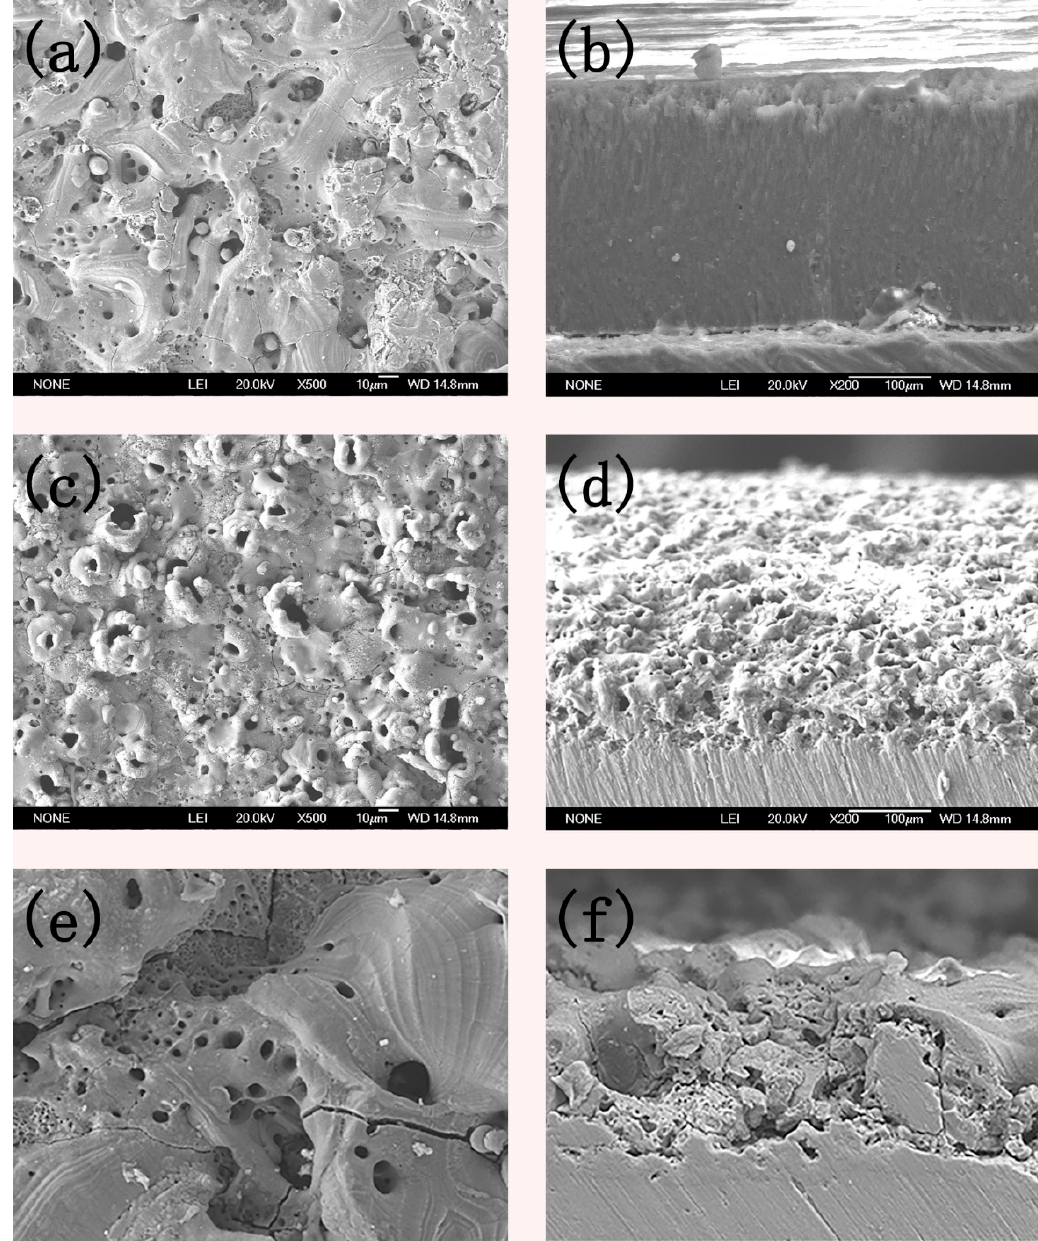
Figure 7. Micro-morphology ( a , c , e ) and cross section ( b , d , f ) of APD coating at discharge time of 5 min ( a , b ), 15 min ( c , d ) and 25 min ( e , f ).